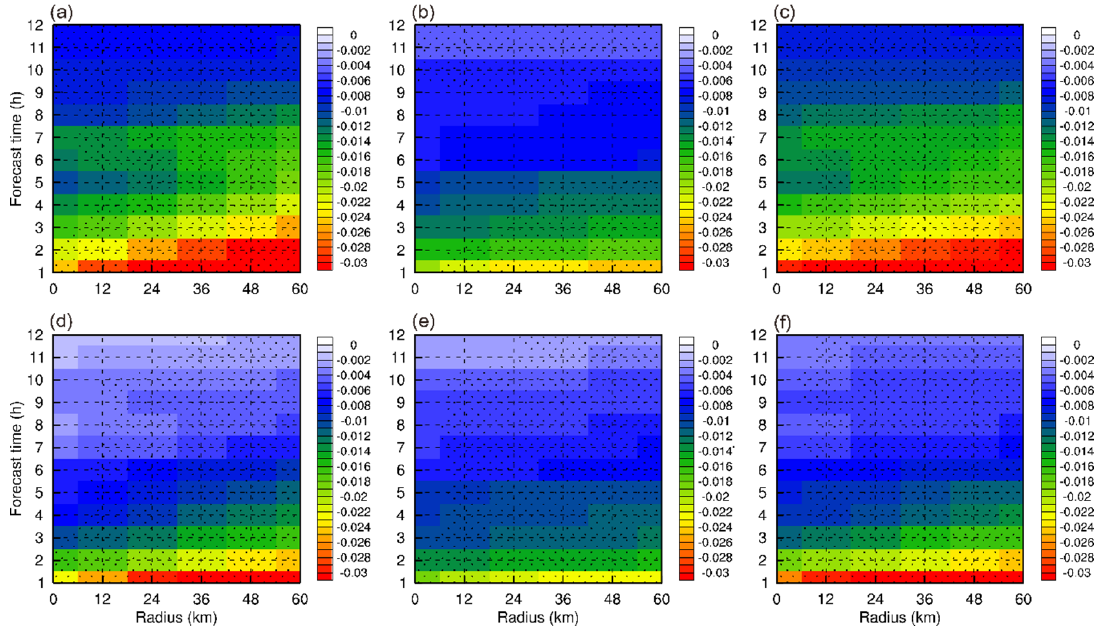
Figure 10. Di ff erences between the fractional Brier score (FBS) of ( a , d ) NEP and GP, ( b , e ) EAS_NEP and GP, and ( c , f ) OBJ_NEP and GP with precipitation thresholds of (top) 1 mm / h and (bottom) 5 mm / h under WF. The dotted areas show the 90% bootstrap confidence